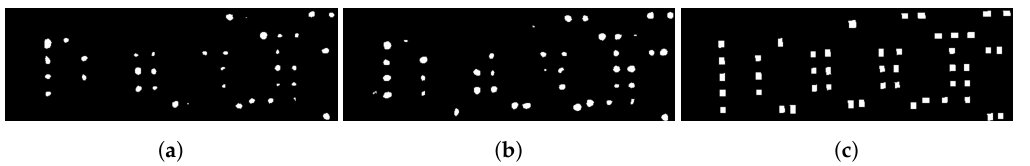
Figure 8. Detailed comparison of multi-spectral vs. RGB information based on FCN4s networks. ( a ) shows the zoomed area of building mask generated by LateConc-PAN&RGB&DSM-mrFCN4s architecture, ( b ) illustrates the building mask obtained from LateConc-PAN&MS&DSM-mrFCN4s model and ( c ) is a ground truth mask. Table 3. Evaluation results regarding the efficiency. Inference on a NVIDIA GeForce Titan X. The superior values are highlighted in bold.